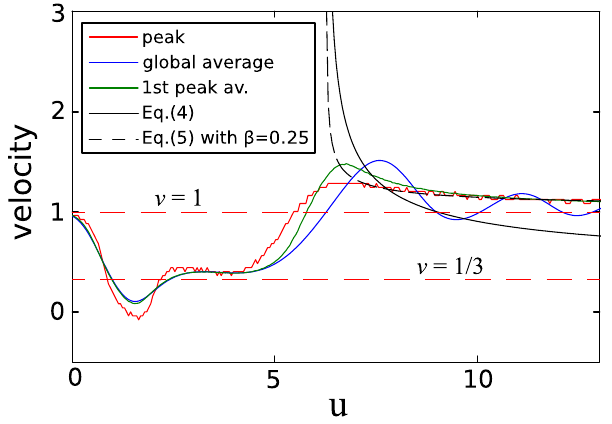
FIG. 2. Pulse velocity calculated from the system of Eq. (1) for the peak of the pulse (red line), for the energy barycenter of the entire pulse (blue line) and the barycenter of the main peak only (green line). The black continuous/dashed lines represent the ζ ð u Þ calculated from Eqs. (4) and (5) pulse peak velocity d þ c du respectively. The horizontal red dashed lines indicate the velocity of light in vacuum ( v ¼ 1 ) and the exponential gain regime theoretical velocity ð v ¼ 1 = 3 Þ